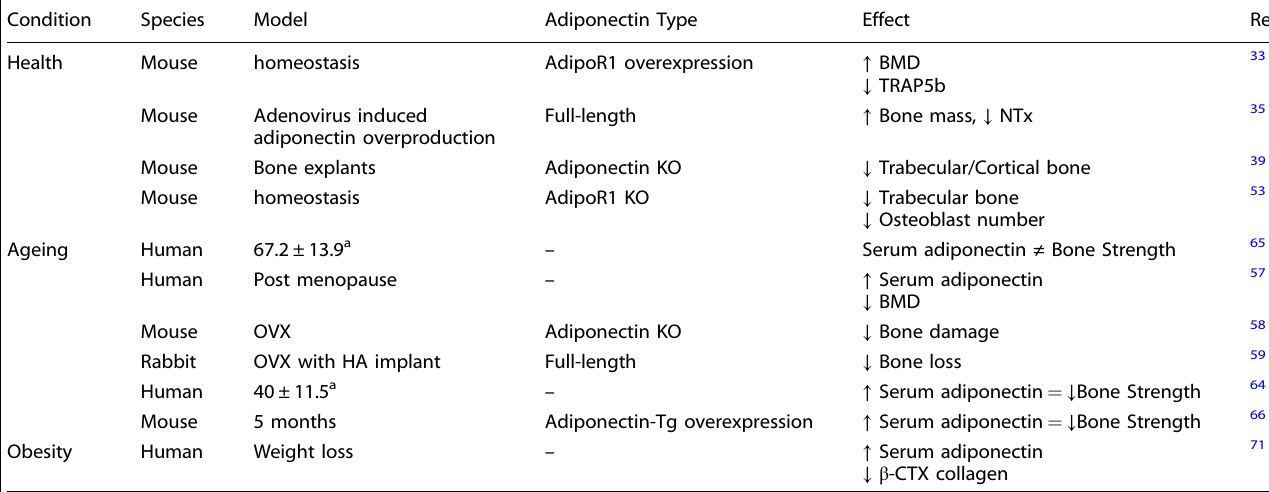
Table 2. In vivo effect of adiponectin in health, ageing and obesity